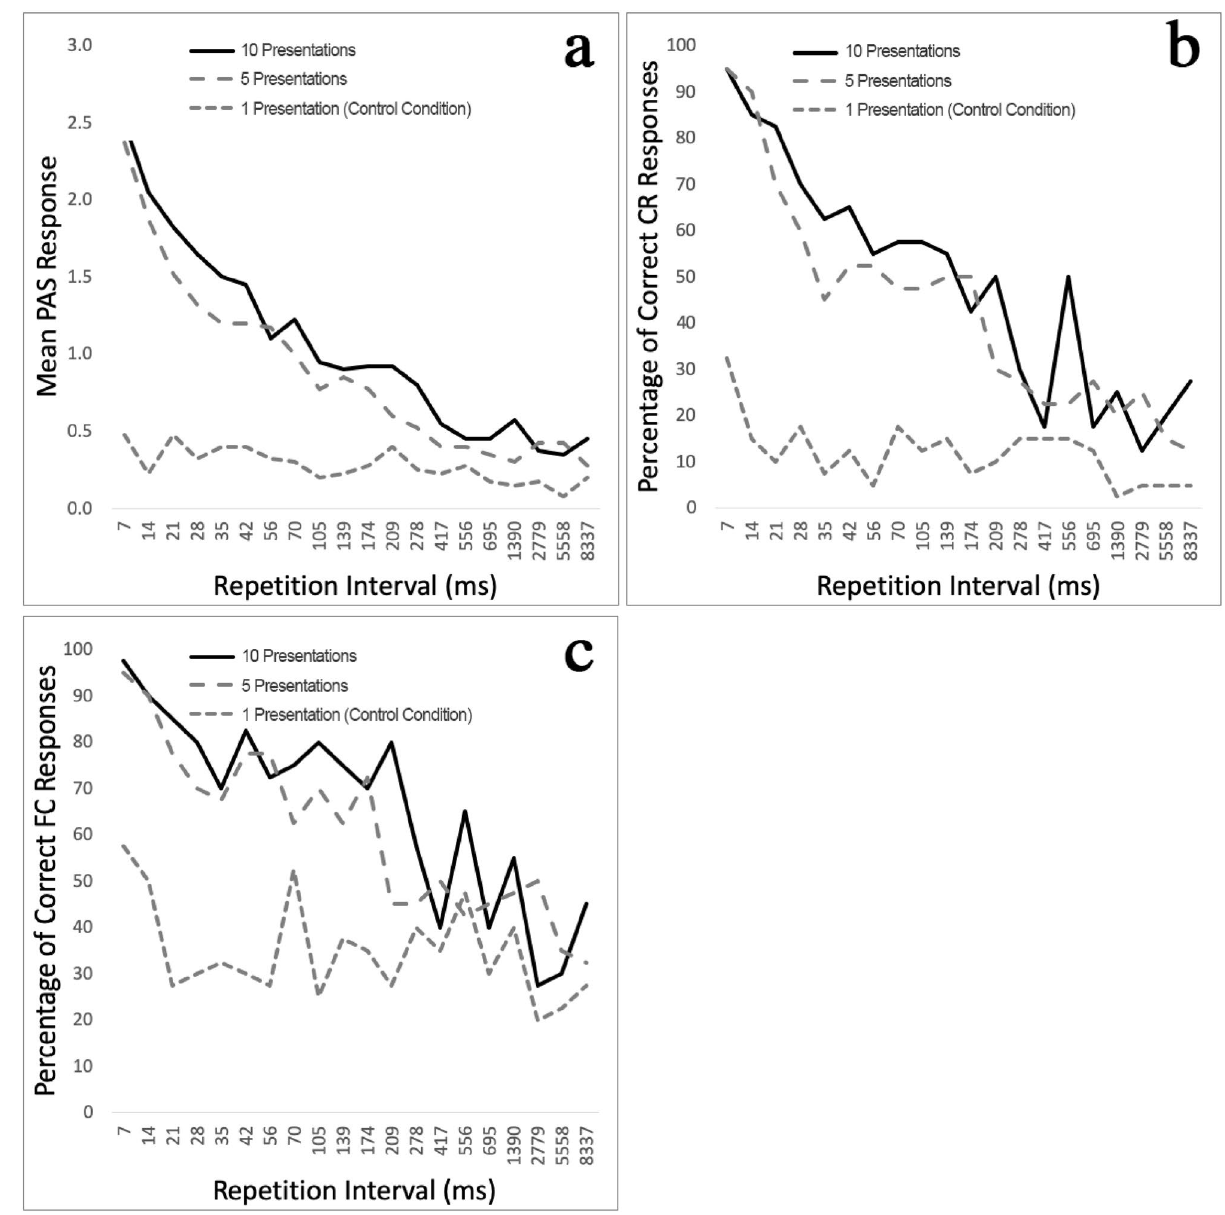
Figure 2. Experiment 1 results of subjective and objective measures of awareness based on the number of presentations and repetition interval timings. Results for all measures were significantly higher when masked stimuli were repeated (10 and five presentations) but decreased as repetition intervals lengthened: ( a ) Mean results of subjective perception ratings measured through the perception-awareness scale (PAS). Objective measures showed the same effects: ( b ) depicts the percentage of correct content reports (CR) while ( c ) shows the percentage of correct forced-choice task (FCT)